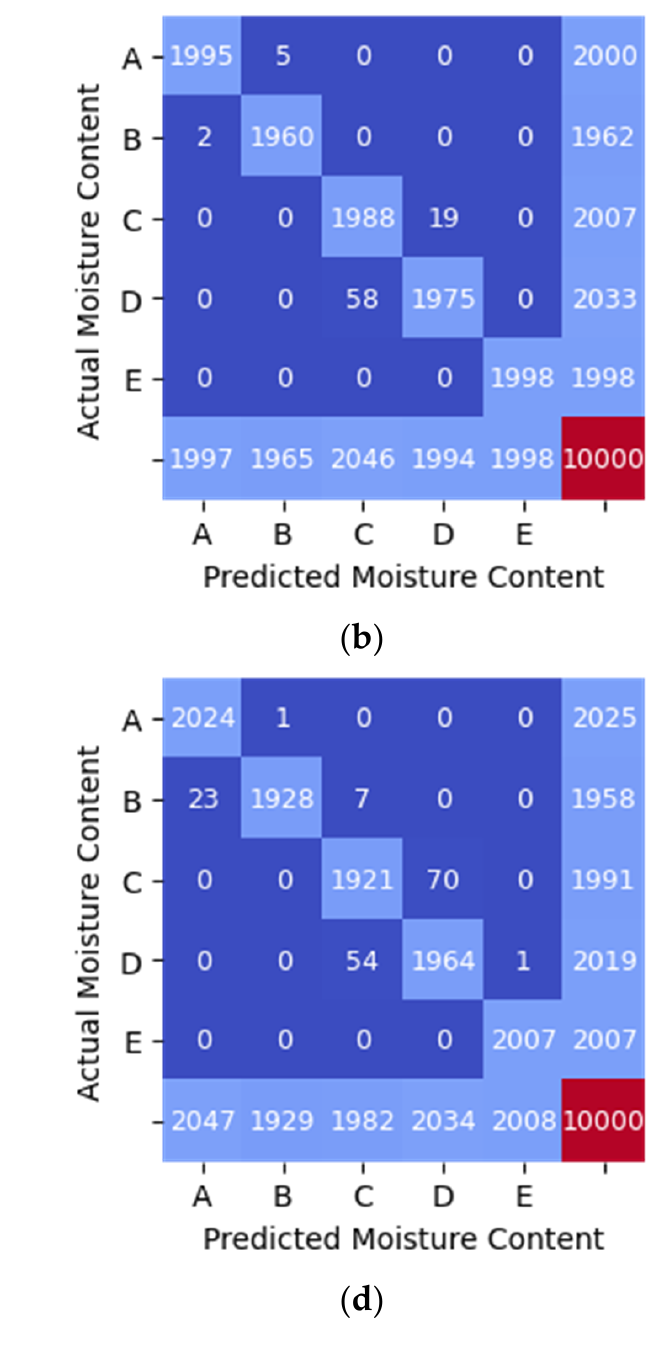
Figure 10. Confusion matrix heatmap of different classification method using 2 features (RSSI_WSN and RSSI_TAG2). ( a ) SVM (linear kernel). ( b ) Random Forest. ( c ) KNN ( n = 5). ( d ) MLP.